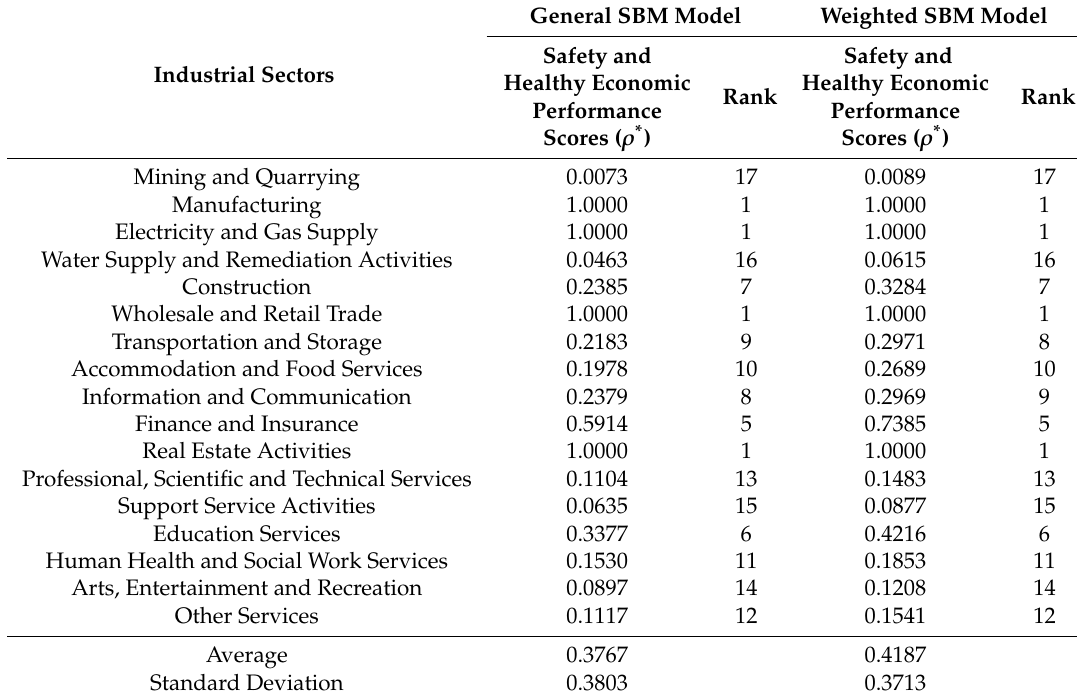
Table 3. Comparison of the general SBM model and the weighted SBM